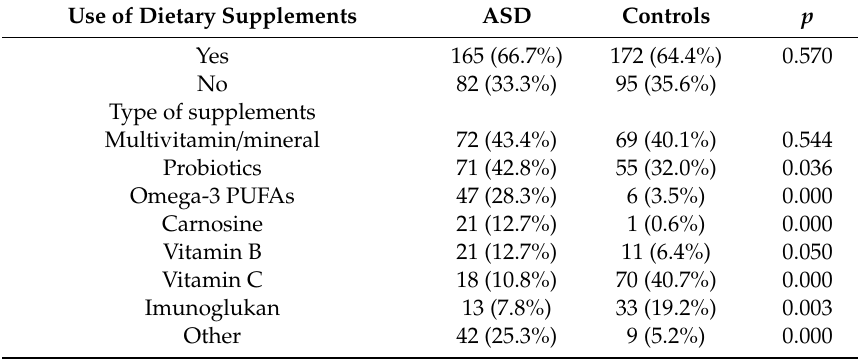
Table 6. Use of dietary supplements in children and adolescents with autism spectrum disorder (ASD) and controls ( n , % of total sample). Use of Dietary Supplements ASD Controls p Yes 165 (66.7%) 172 (64.4%) No 82 (33.3%) 95 (35.6%) Type of supplements Multivitamin / mineral 72 (43.4%) Probiotics